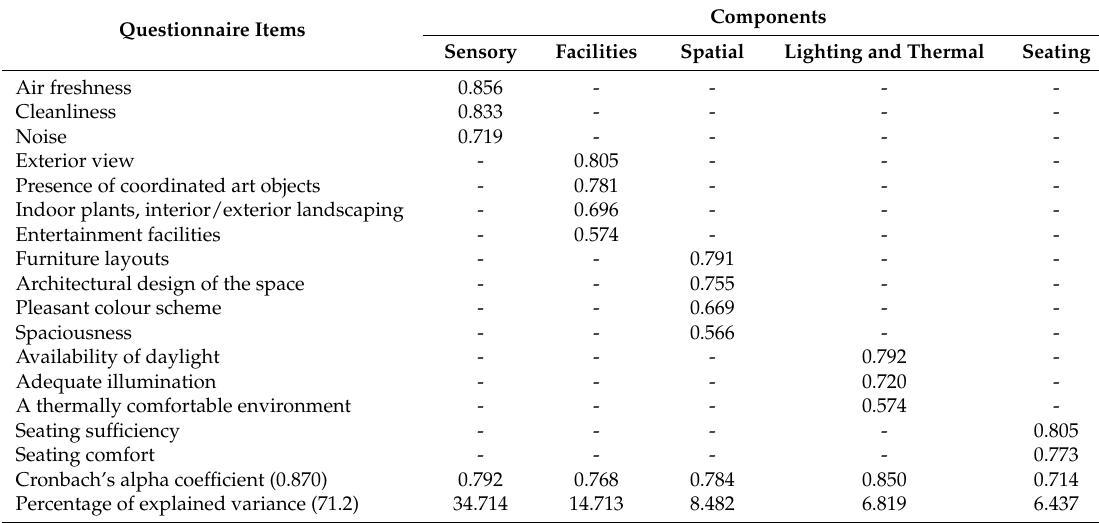
Table 3. Rotated component matrix of questionnaire